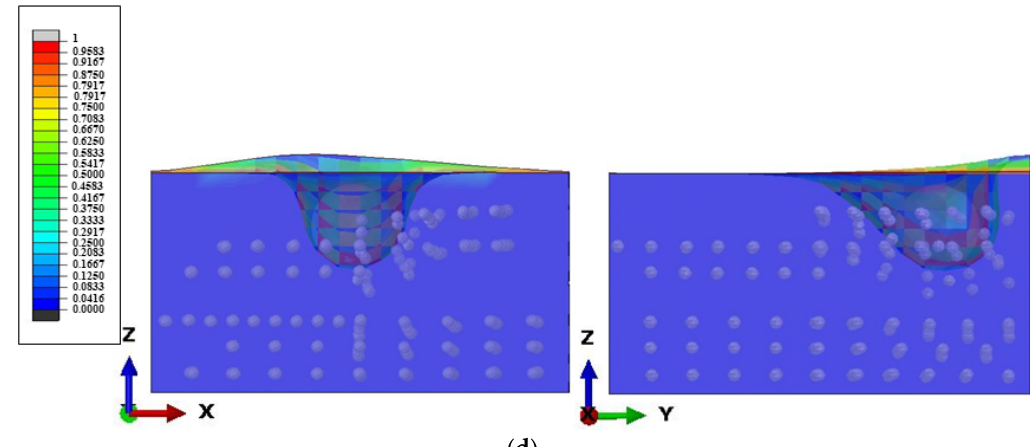
Figure 8. Particle clustering effect under ( a ) 10 Pa·s viscosity, ( b ) 20 Pa·s viscosity, ( c ) 30 Pa·s viscosity, ( d ) 40 Pa·s viscosity.